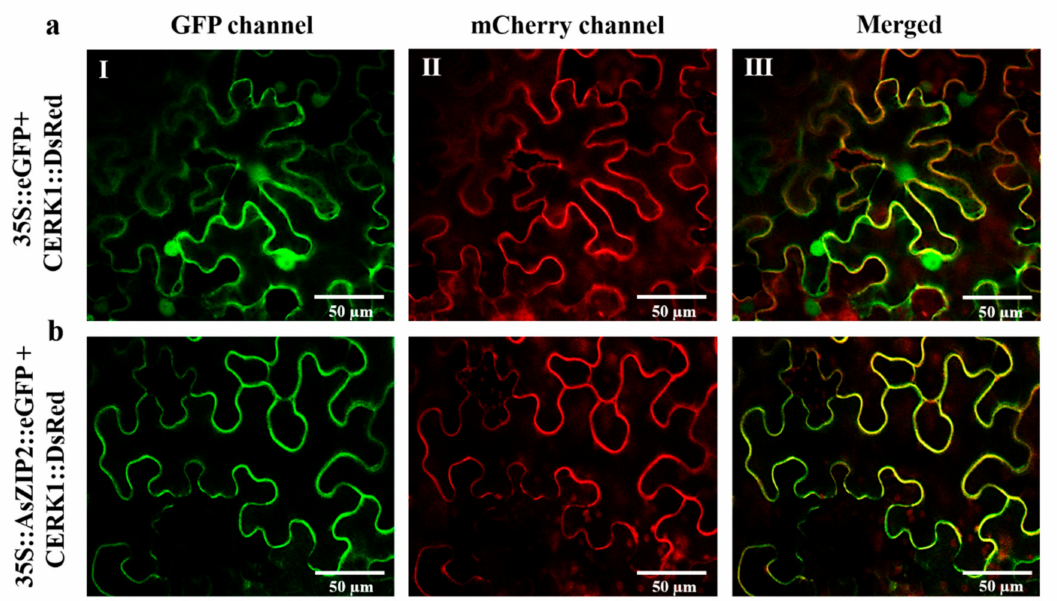
Figure 7. Subcellular localization of the AsZIP2 transporter in plant cells. ( a , b ) Confocal laser scanning microscopy images of N. benthamiana leaf epidermal cells transiently coexpressing either 35S::eGFP ( a ) or 35S::AsZIP2::eGFP ( b ) with the plasma membrane marker CERK1::DsRed driven by the 35S promoter. Left panel (I): GFP channel; center panel (II): mCherry channel; right panel (III): Merged. Scale bar, 50 µ